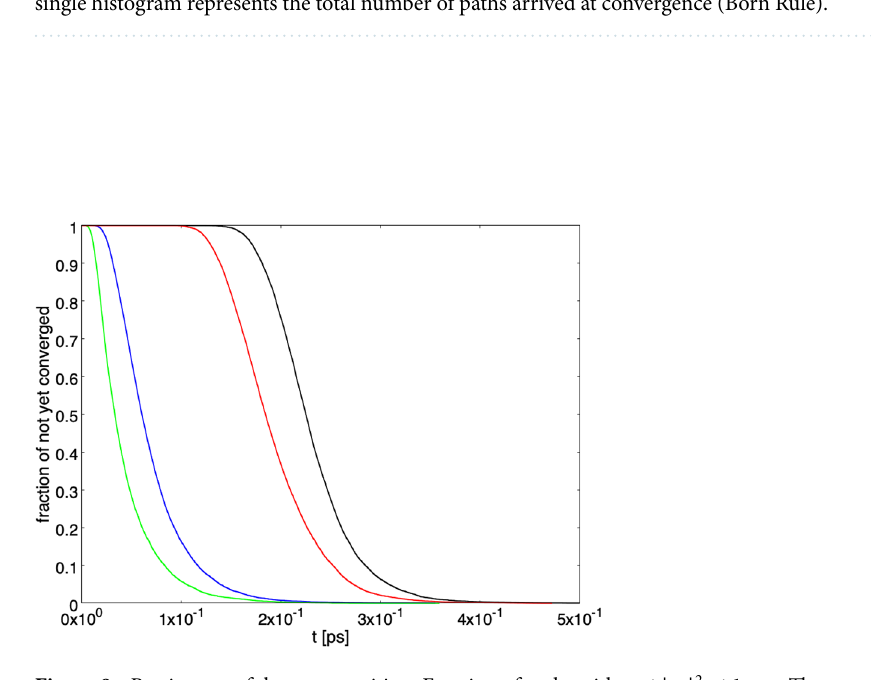
2 = 1 ∕ 20 and 1/2, respectively, without the von Neumann activation. c R | |